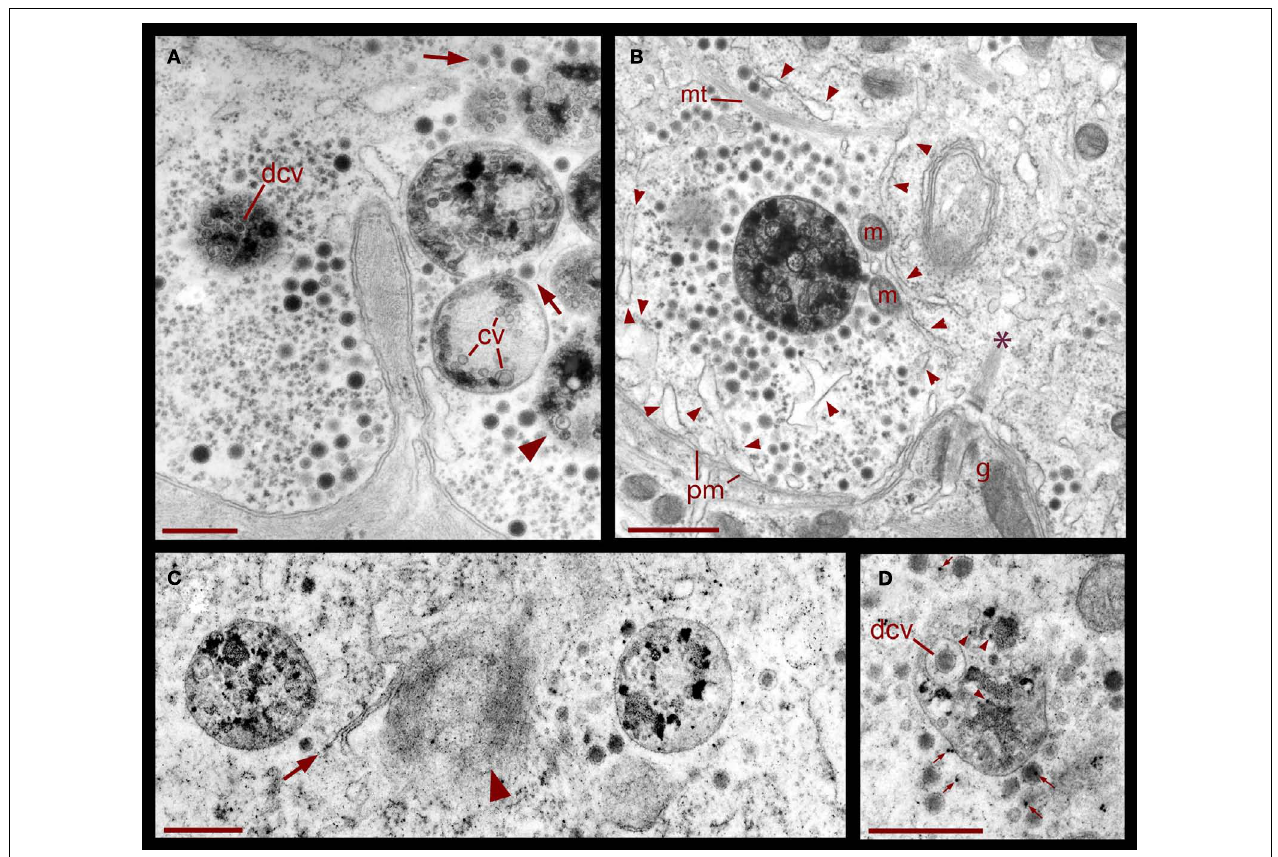
(arrowheads), microtubules (mt), and mitochondria (m). Asterisk marks a bundle of microtubules attached to the plasma membrane through a hemi-desmosome. Stimulation was as in (A) . (C) Formation of a multivesicular body (arrow) with microtubule coiling (arrowhead). (D) A multivesicular body after the neuron was stimulated in the presence of extracellular peroxidase, displaying gold marks, and containing clear and dense core vesicles (dcv). Arrowheads point to gold particles inside multivesicular bodies and small arrows point to gold particles on top of vesicles and membrane corpses, maybe produced upon endocytosis. Scale bar = 1 μ